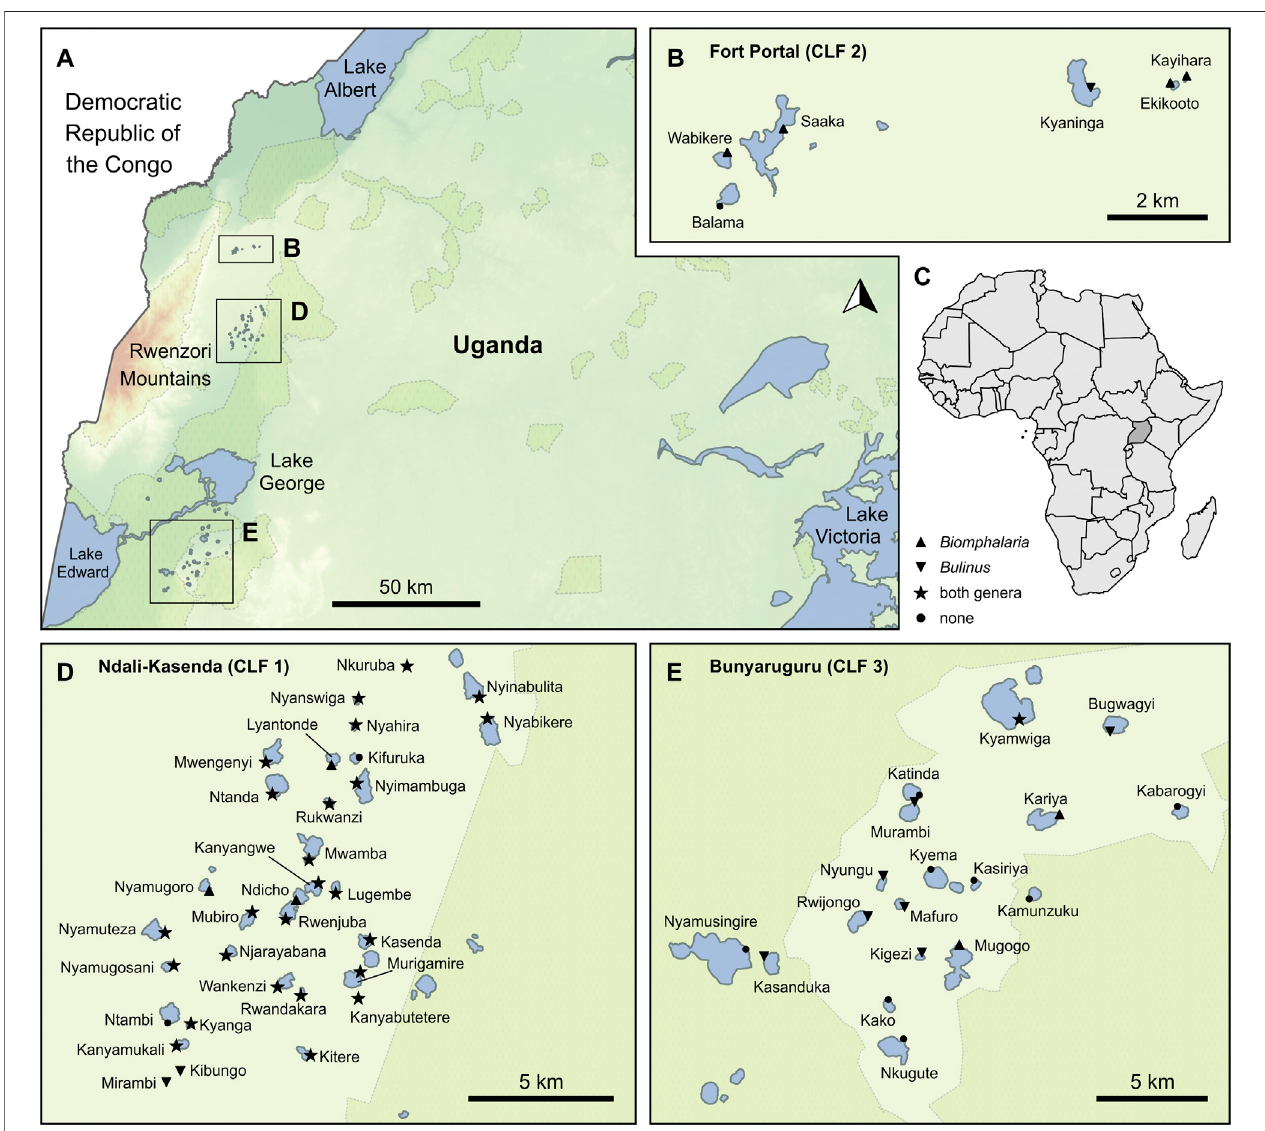
FIGURE1| Studyareaand occurrences ofintermediatehost(IH)snails.Three craterlake fi elds(CLF1 – 3) (B,D,E) inwesternUganda (A) inAfrica (C) werestudied. Symbolsat sampledlakesindicate the presence of Biomphalaria (triangle), Bulinus (inverted triangle), and both genera combined (dark star), whereas lakesmarked with a small circle indicate localities where no IH snail was